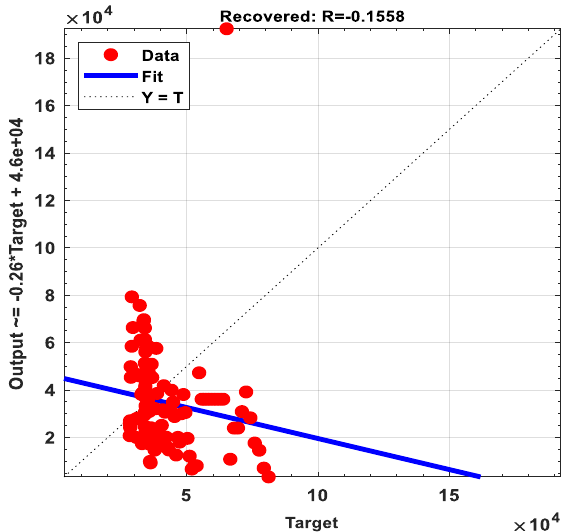
Figure 7. The training data and predicted data of COVID-19 infected people in Mexico. On the other hand, the expected recovery and daily deaths decrease with the end of this year, as shown in Figures 8 and 9. Note that Figure 8 shows the training data (in Red) and ANN-based predicted data (in Blue) of recovered cases from COVID-19 in Mexico where the training data covers the duration from 13 May 2020, to 3 August 2020. In con- trast, the ANN-based expected number of recovered cases covers data from 13 May 2020, to 17 January 2021.